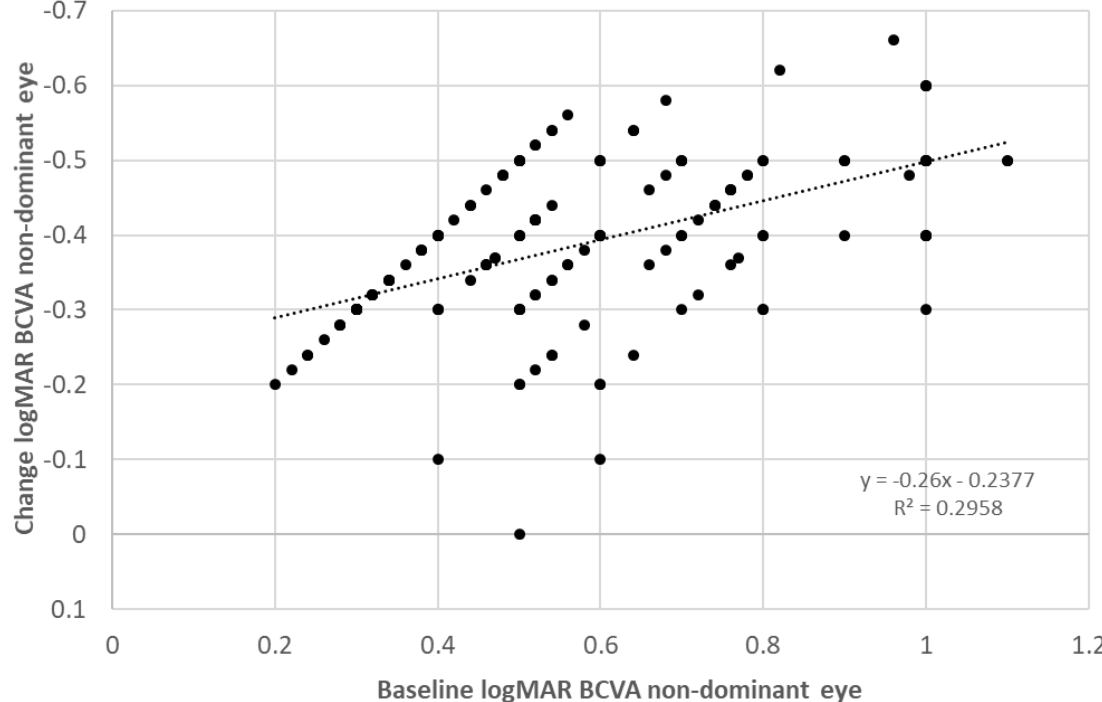
Figure 3. Scatter plot showing the relationship between the change in best corrected visual acuity (BCVA) in the non-dominant eye and the baseline BCVA in such eye. The adjusting line to the data obtained by means of the least-squares fit is shown.